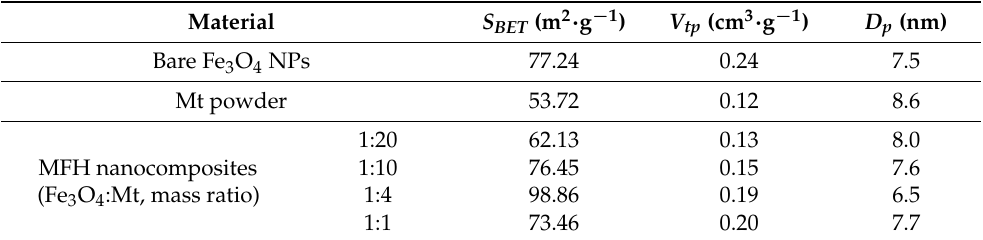
Table 1. The specific surface area and porous features of different materials.